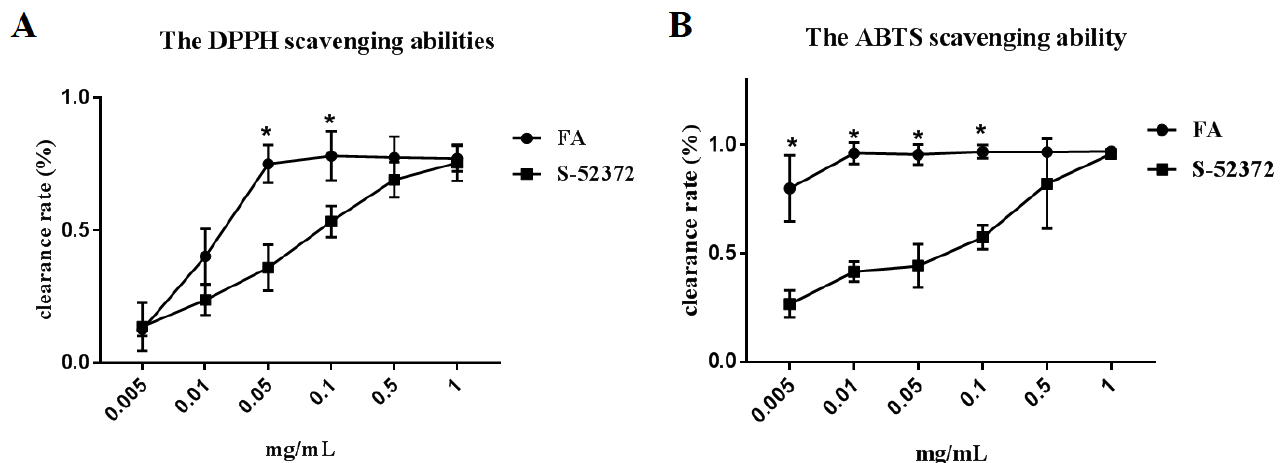
Figure 4. The graph of free radical scavenging ability. ( A ) The DPPH scavenging abilities of FA and its skeleton derivative, S-52372. ( B ) The ABTS scavenging ability of FA and its skeleton derivative S-52372. * p < 0.05 means FA compared with corresponding concentration of S-52372 group.